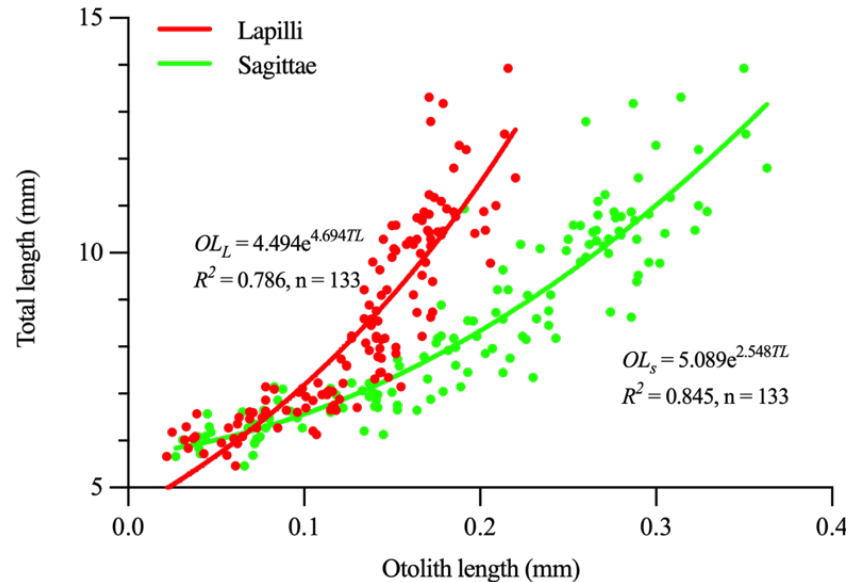
Figure 5. The relationship between otolith length of lapilli or sagittae and total length of Sinogastromyzon wui .